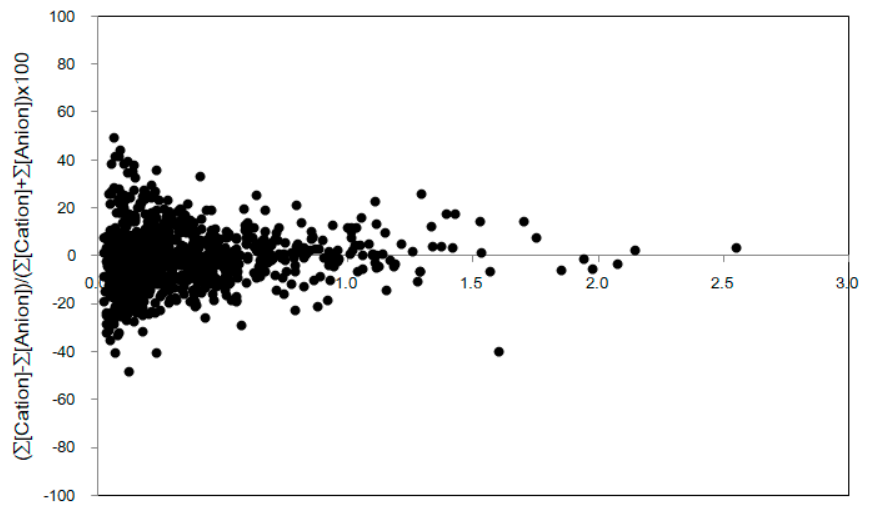
Figure 2. Scattergram of (( ∑ Cation − ∑ Anion)/( ∑ Cation + ∑ Anion)) × 100 versus ( ∑ Cation + ∑